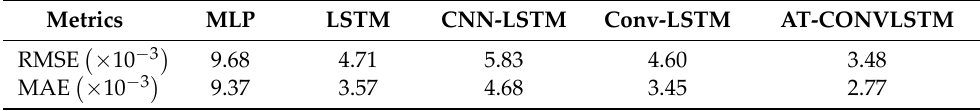
Table 5. Comparison of the average error between the proposed algorithm and other methods. Metrics